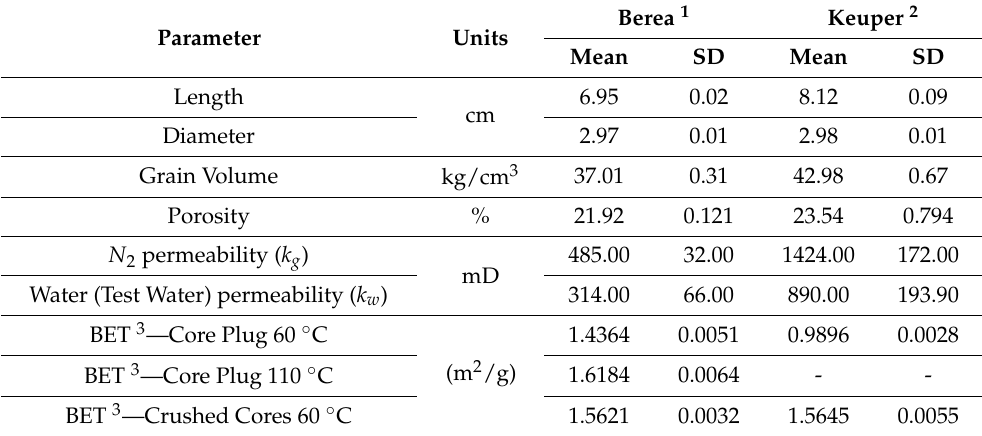
Table 1. Overall core and saturation data for the outcrop samples used in this work.